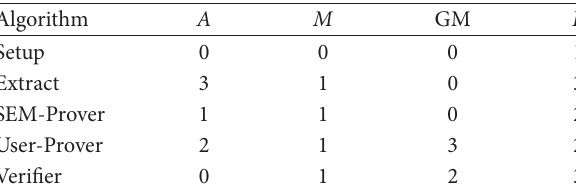
Table 1: Operation costs for the GQ-SM-IBI scheme.